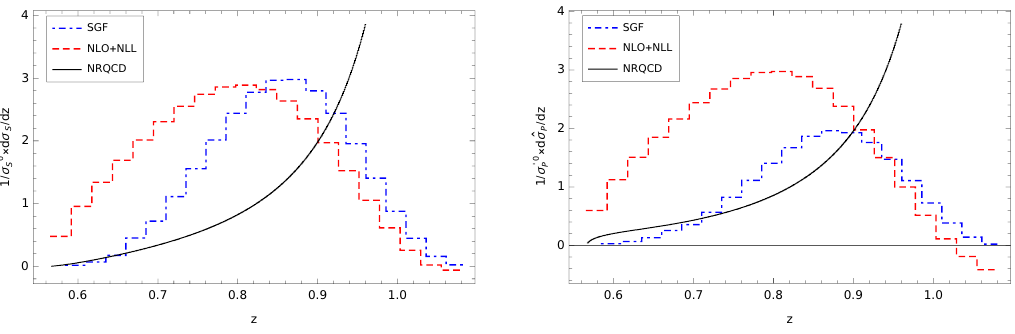
Figure 4 . The differential cross sections in SGF and NRQCD factorization approaches. on the left of that in SGF. We also find that, comparing to the NLO+NLL results, the SGF results are significantly suppressed at moderate z , especially for the P-wave